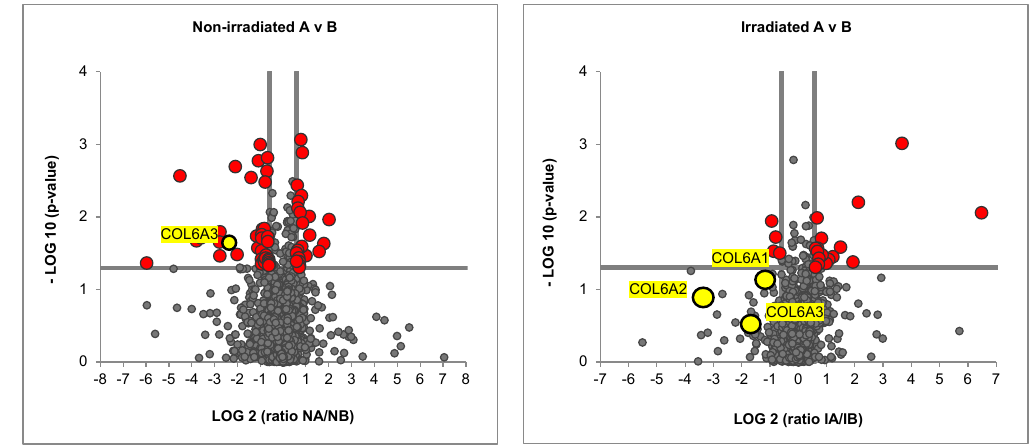
Figure 2. Proteomic Analysis of non–irradiated and irradiated co-cultures. Volcano plot showing significantly differently abundant proteins in irradiated TNBC matrix versus irradiated healthy matrix (red data points). Three yellow data points below the horizontal line of significance represent the three strands of collagen VI, COL6A1, COL6A2 and